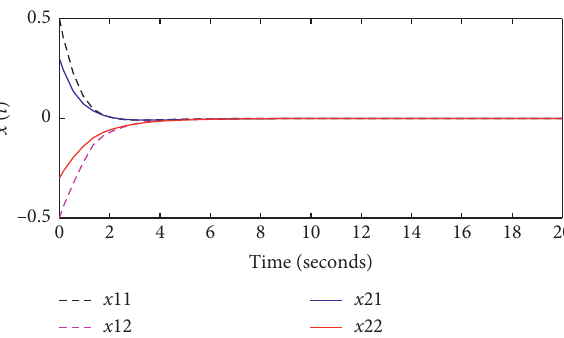
Figure 2: State trajectories x ( t ) of the cyber-attacked networked control